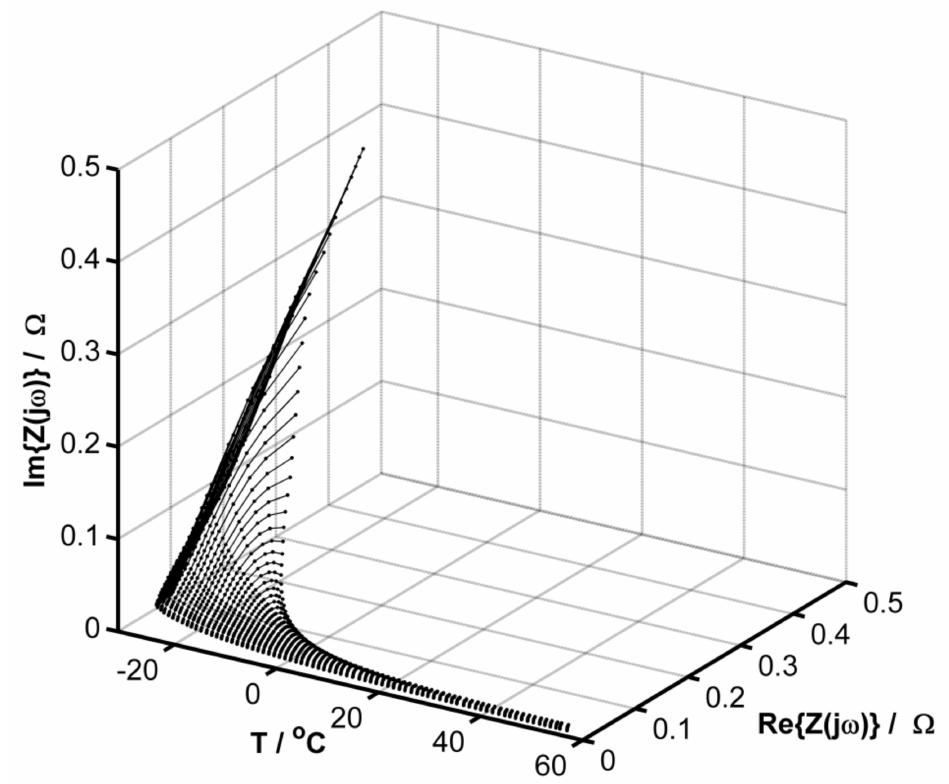
Figure 1. Impedance graph recorded for the tested LiC during dynamic temperature change in the range from − 30 to 60 degrees Celsius in the galvanostatic mode for SoC = 0% (2.2